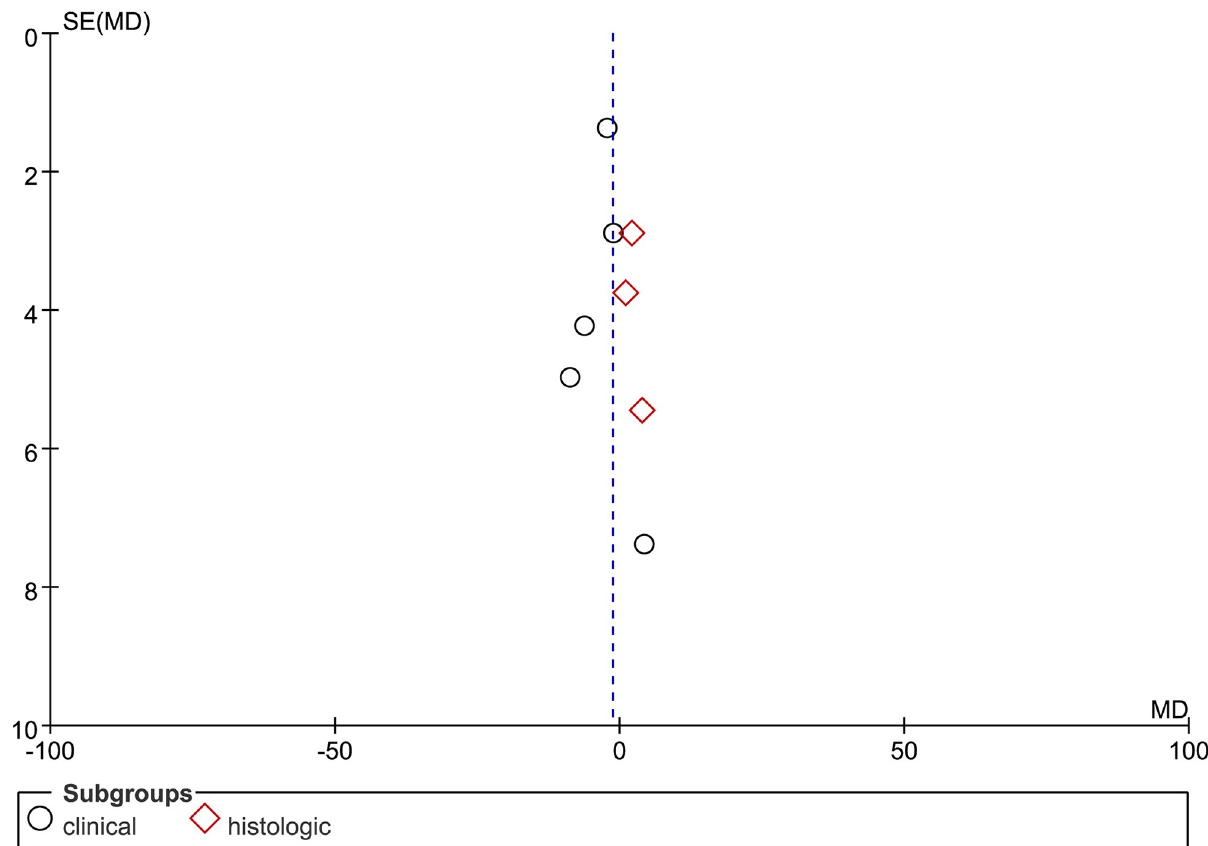
Fig 5. The funnel plot for publication bias test. Funnel plot with pseudo 95% CI of PDI.